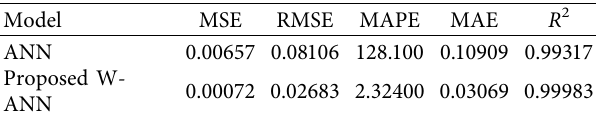
Table 1: Accuracy of the proposed